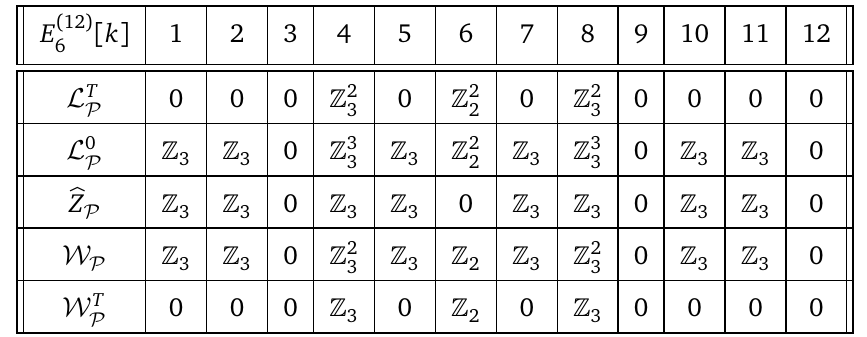
Table 10: Various contributions to the defect group for the untwisted punctures ( 12 ) [ k ] of type E P N = ( 2,0 ) theory. The columns parametrize different values of 6 6 k . The results can be extended beyond this table as they only depend on k ( mod 12 ) .